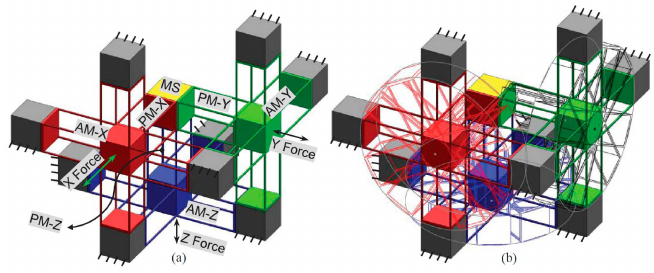
Figure 3. AM design based on the freedom and constraint topology approach: ( a ) the selectable constraints, ( b ) constraint selection and ( c ) the designed AM and its DOF.